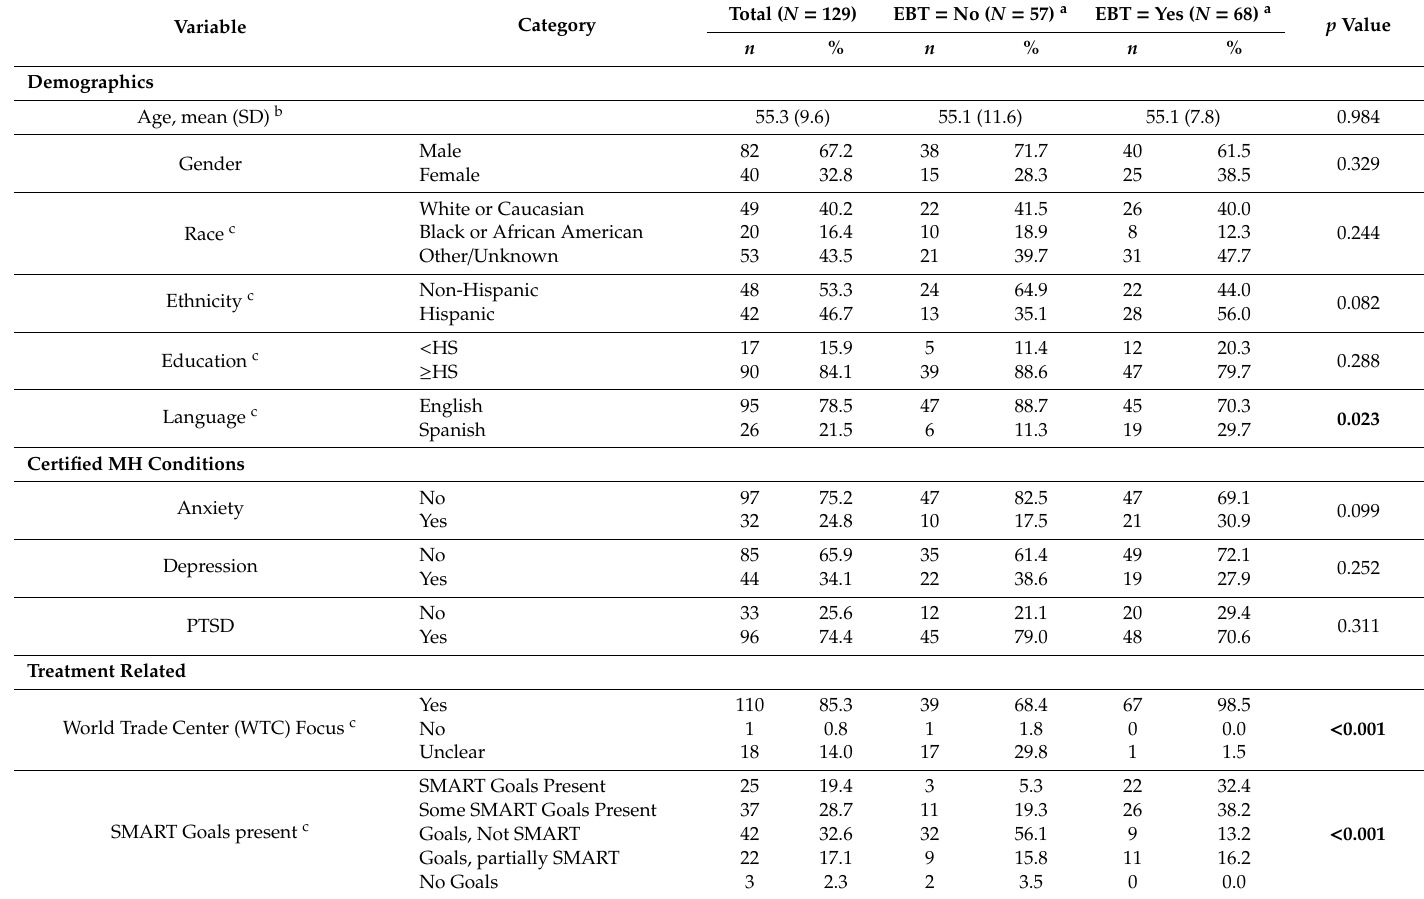
Table 2. Characteristics (%) compared by reviewer-assessed EBT